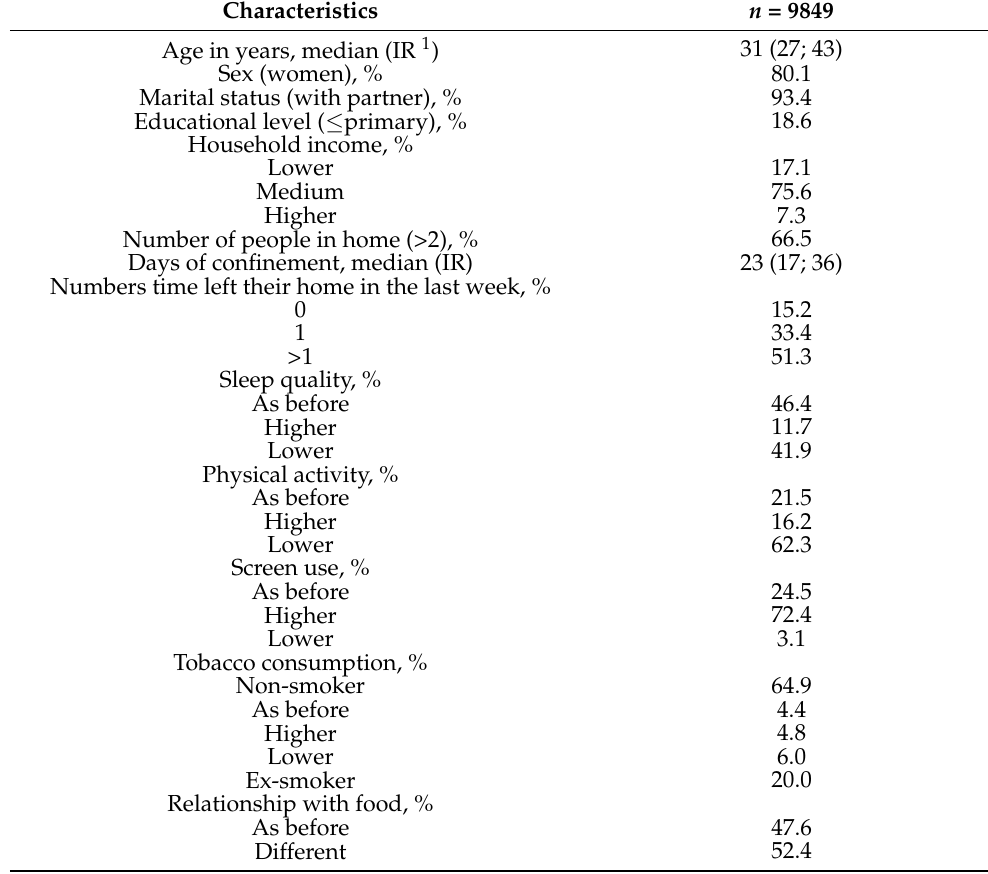
Table 1. Sociodemographic and lifestyle characteristics of the participants in the CoV-Eat